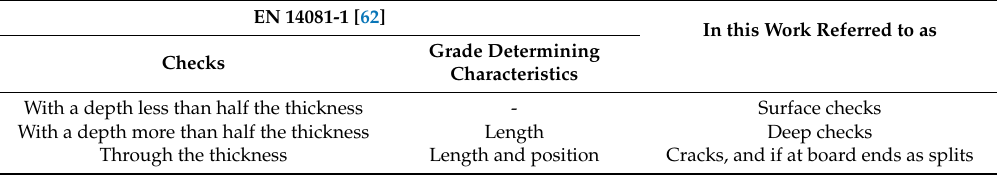
Table 2. Classification of